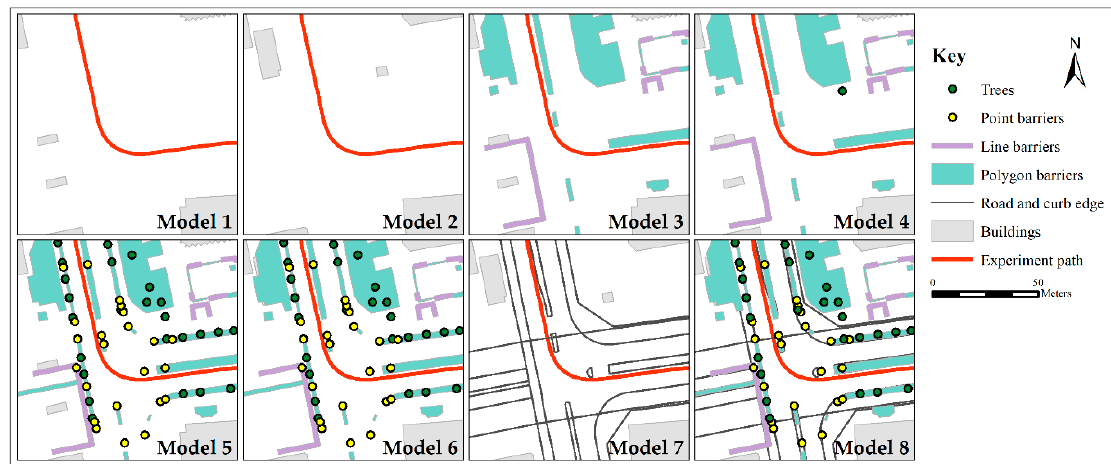
Figure 9. Maps showing the different data layers in each of the eight models as described in Table 4.